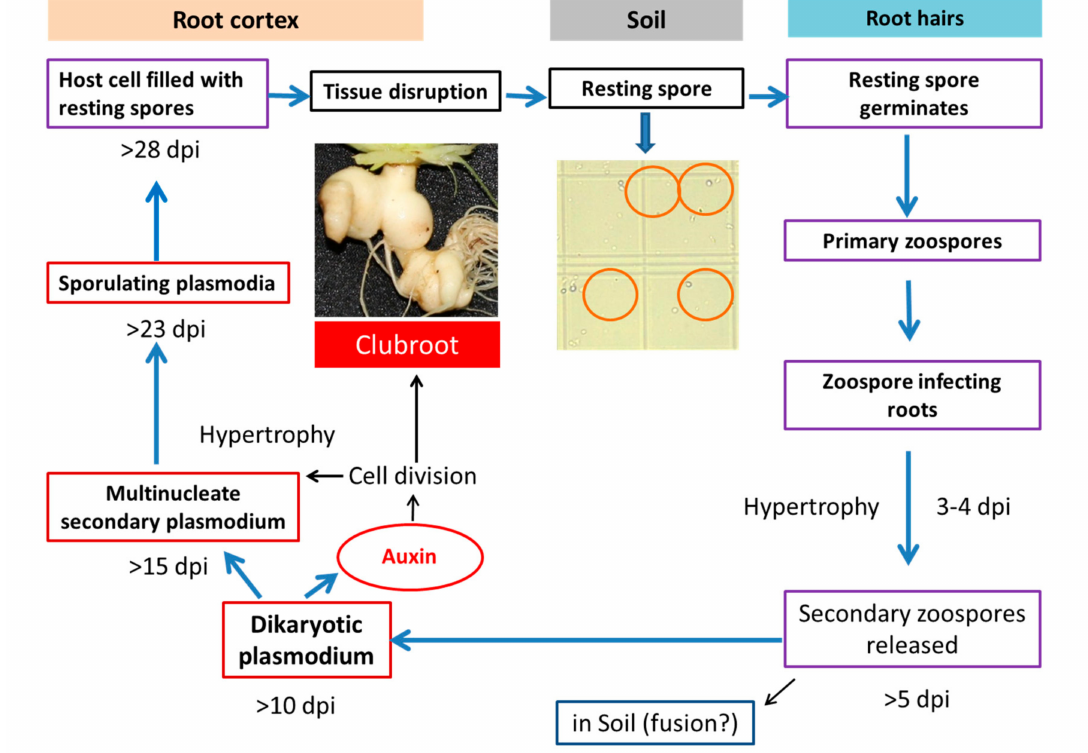
Figure 1. Involvement of auxin in clubroot formation during the life cycle of Plasmodiophora